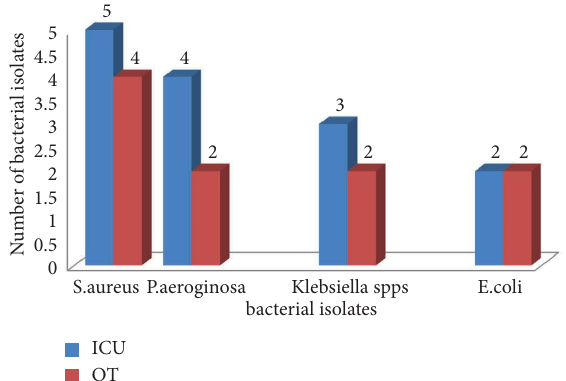
Figure 3: Distribution of air-borne bacterial isolates from ICU and OT wards at WSUCH, Wolaita Sodo, Ethiopia, 2021. Table 3: Antimicrobial resistance pattern of air-borne bacterial isolates at WSUCH, Wolaita Sodo, Ethiopia, 2021. Bacterial Isolates Pattern